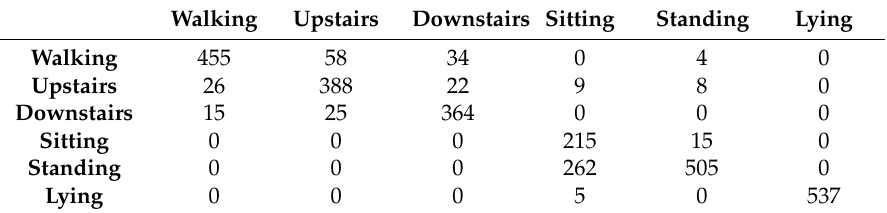
Table 8. Confusion matrix for non-hierarchical class dependent feature selection.